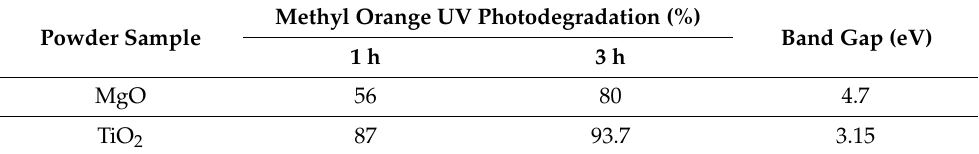
Table 2. Methyl orange photodegradation activity of TiO 2 and MgO nanopowders and their band gap values.